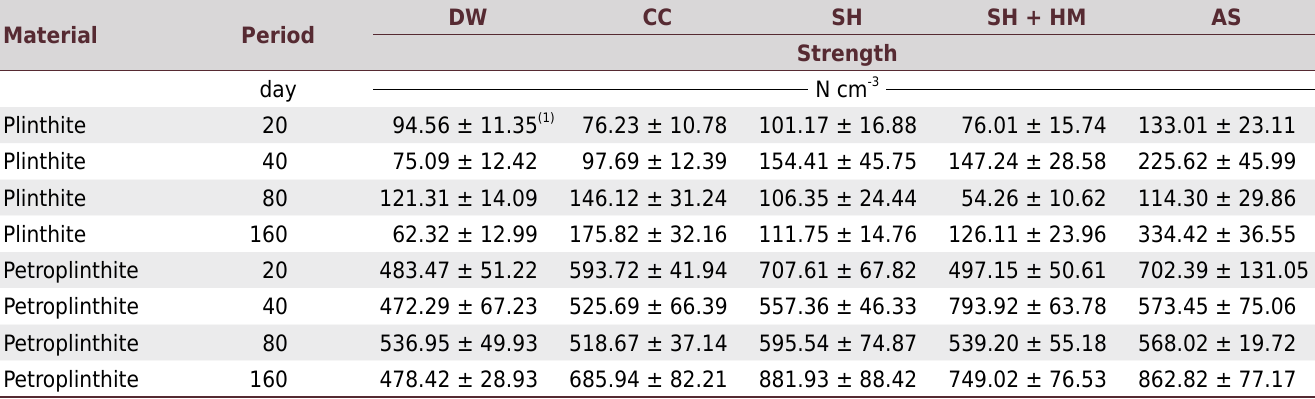
Table 8. Mean value and standard error of the mean compressive strength of the plinthite and petroplinthite subsamples in the soil profiles, immersed in different solutions for different periods